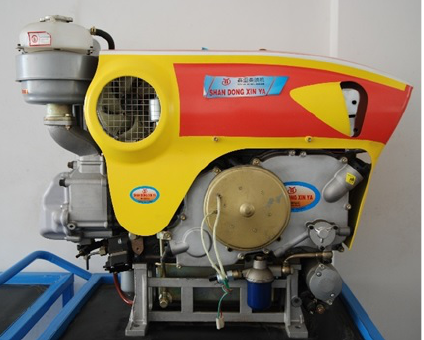
Figure 1. The DK32 engine designed by Tsinghua